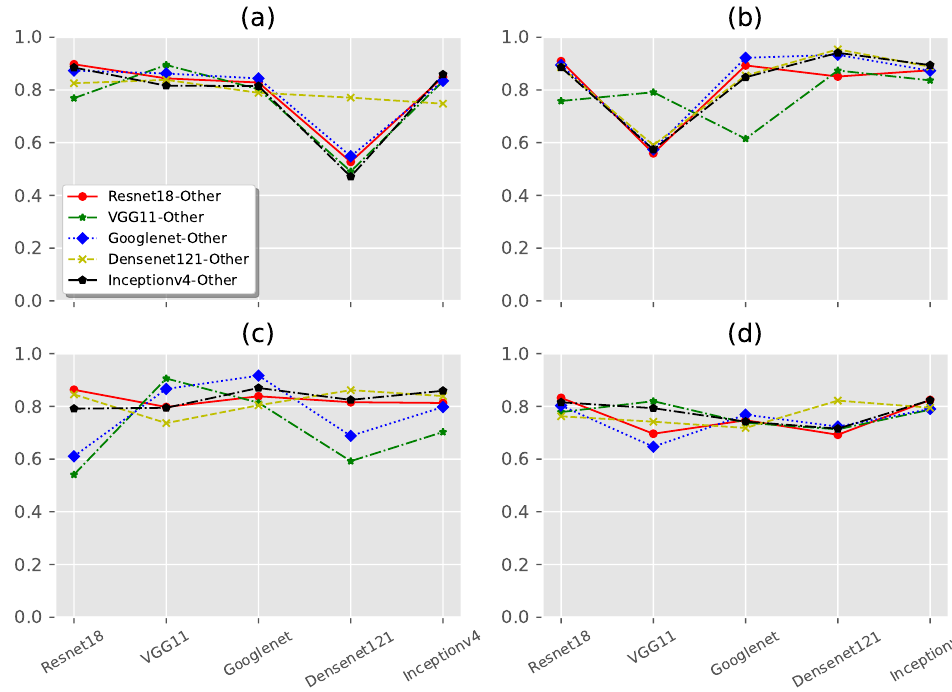
Figure 4. The generalizability for target model architecture. ( a , b ) are the experimental results of ADV on CIFAR10 and CIFAR100. ( c , d ) are the experimental results of GBI on CIFAR10 and CIFAR100.